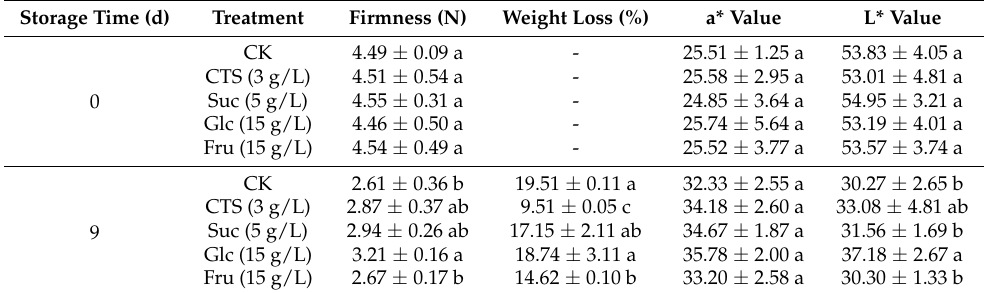
Table 1. Effects of chitosan (3 g/L), sucrose (5 g/L), glucose (15 g/L), and fructose (15 g/L) on the firmness, weight loss, a* value, and L* value of strawberry fruits stored at 15 ± 2 ◦ C for 0 and 9 d.